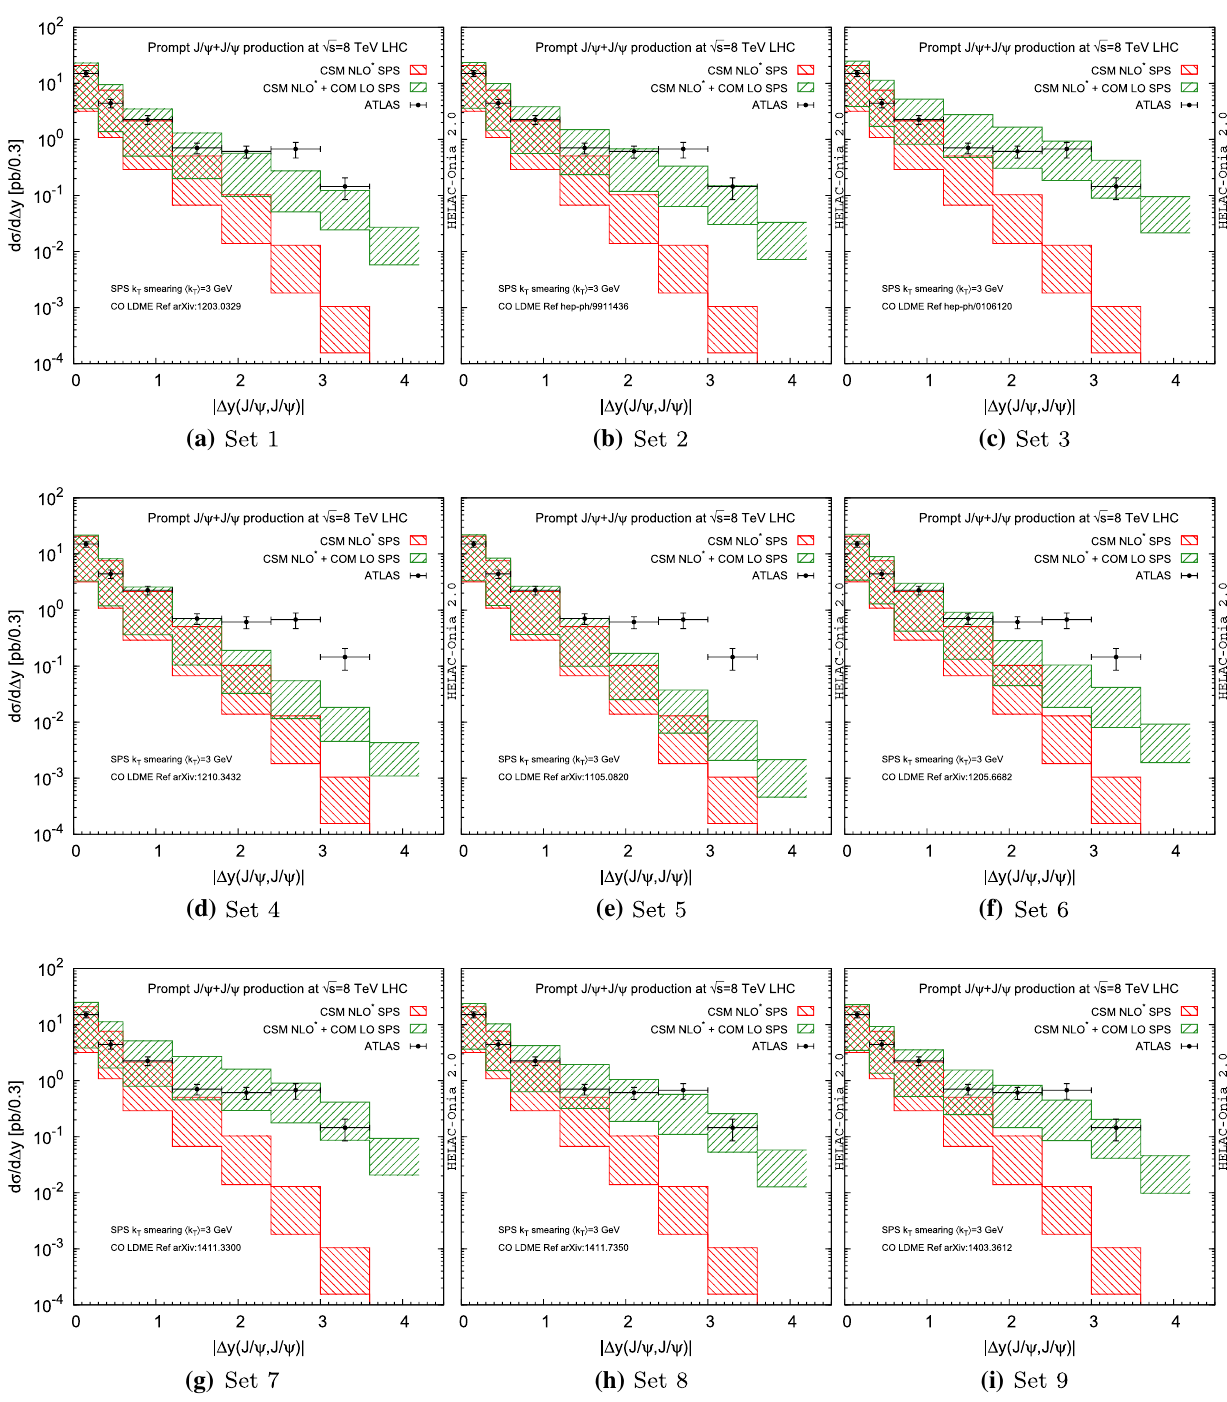
√ s = 8 TeV acceptance